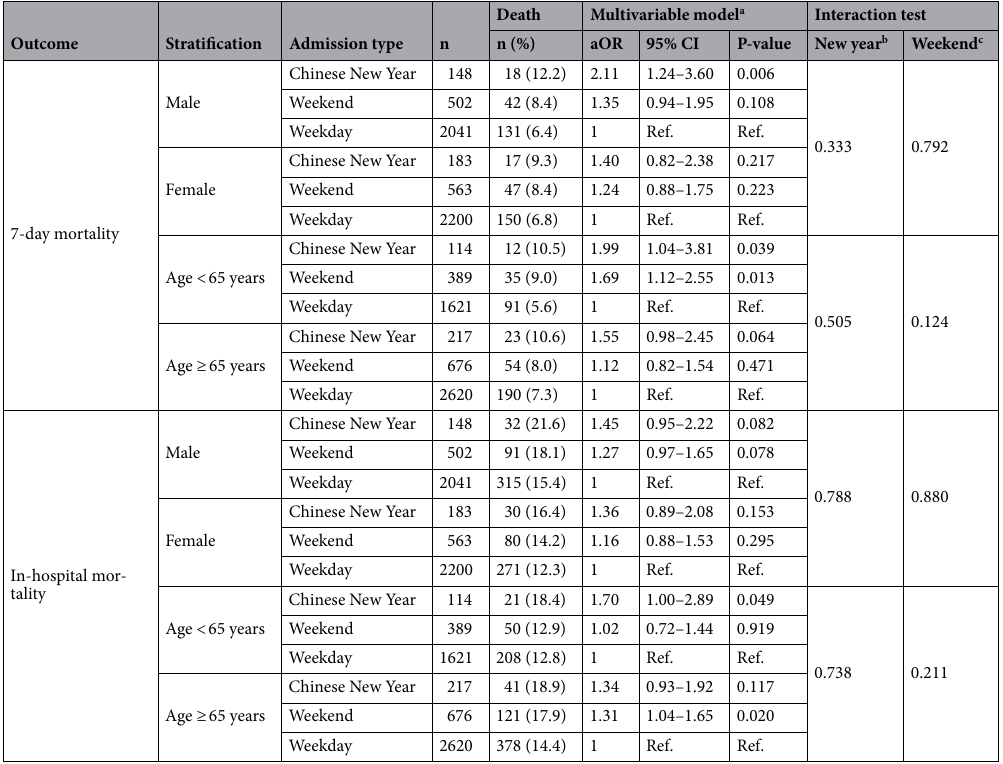
Table 3. Sex- and age-stratified analyses of the risk of mortality from pulmonary embolism between the three admissions groups: Chinese New Year holiday, weekend, and weekday. aOR adjusted odds ratio, CI confidence interval, n number, Ref. reference. a Multivariable logistic regression model with adjustments for all covariates listed in Table 1. b The interaction test was performed to determine whether the association between the Chinese New Year holiday admission ( vs . weekday admission) and the risk of mortality differed significantly according to age and sex. c The interaction test was performed to determine whether the association between weekend admission (vs. weekday admission) and the risk of mortality differed significantly according to age and